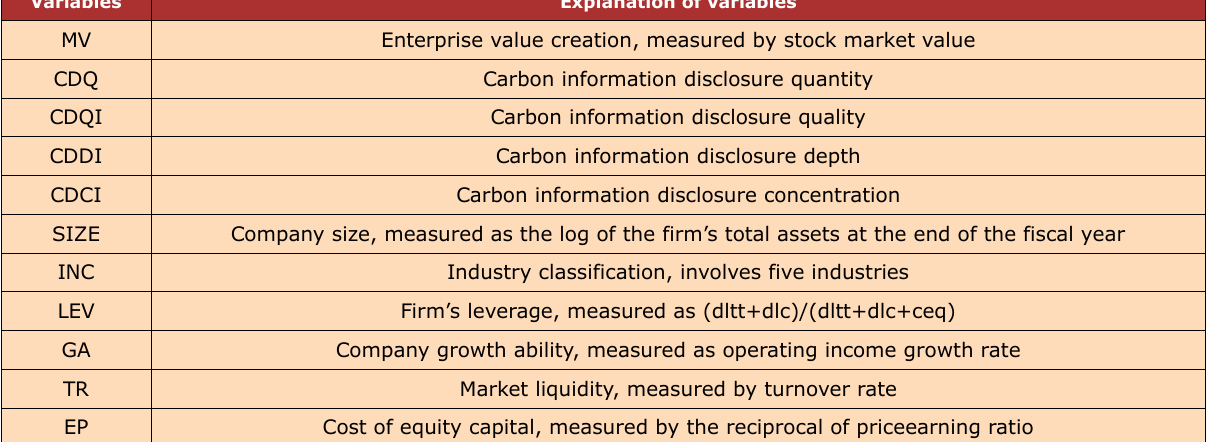
Table 1. Explanation of variables in